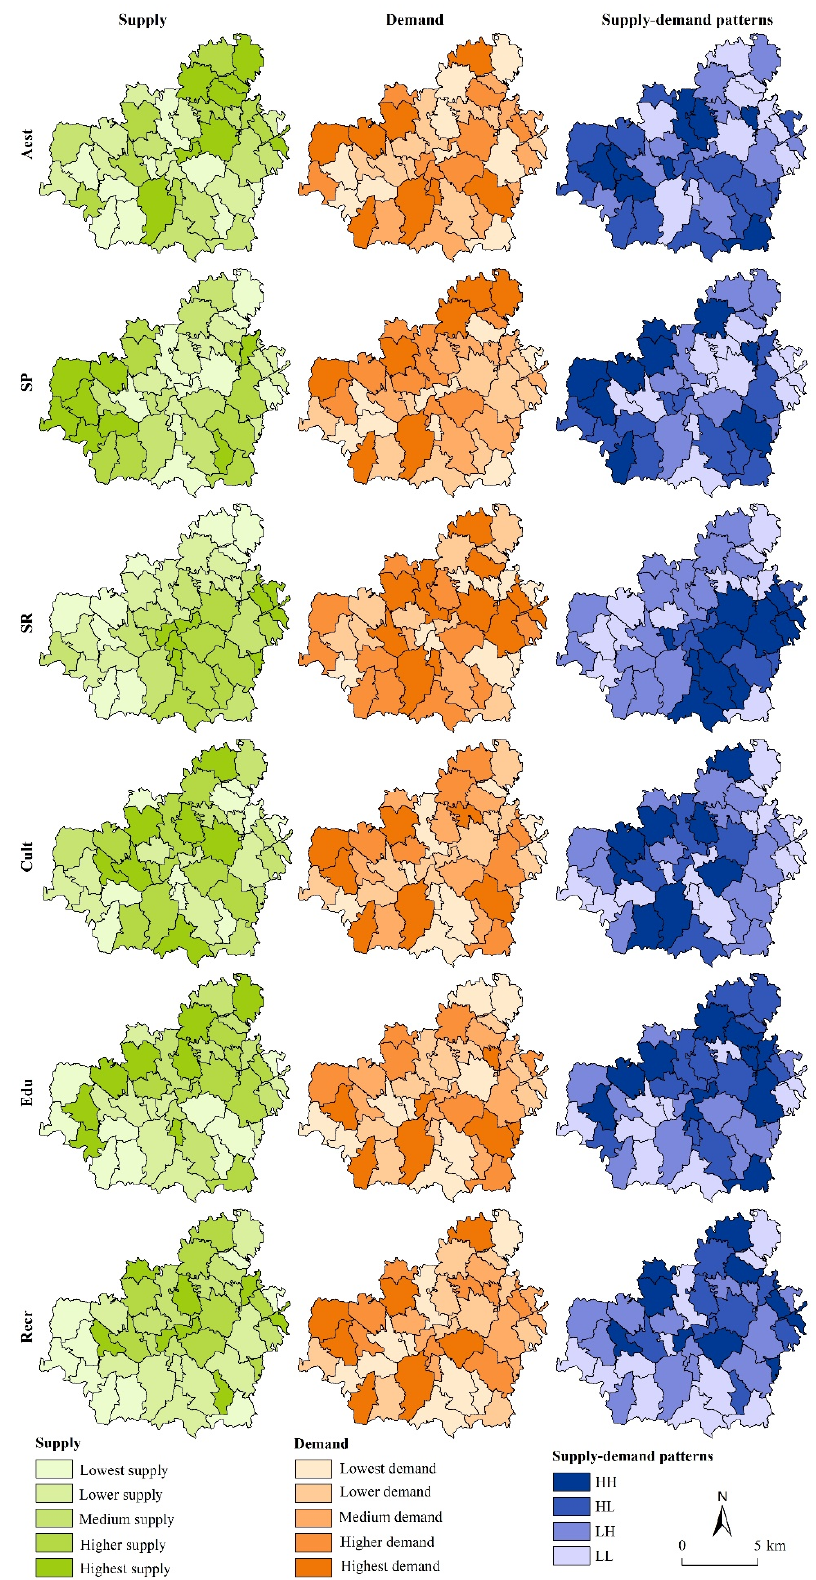
Figure 2. Spatial distribution of supply, demand and supply–demand patterns of cultural ecosystem services in Shigou Township. HH: high supply–high demand; HL: high supply–low demand; LH: low supply–high demand; LL: low supply–low demand.